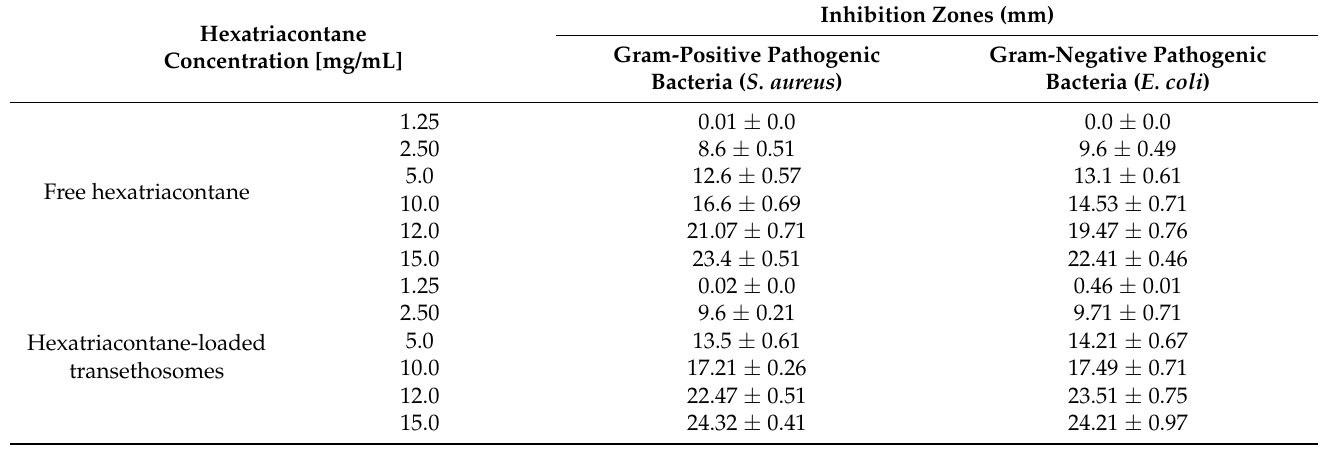
Table 5. Minimum inhibitory concentrations (MICs) of HTC for E. coli and S. aureus.